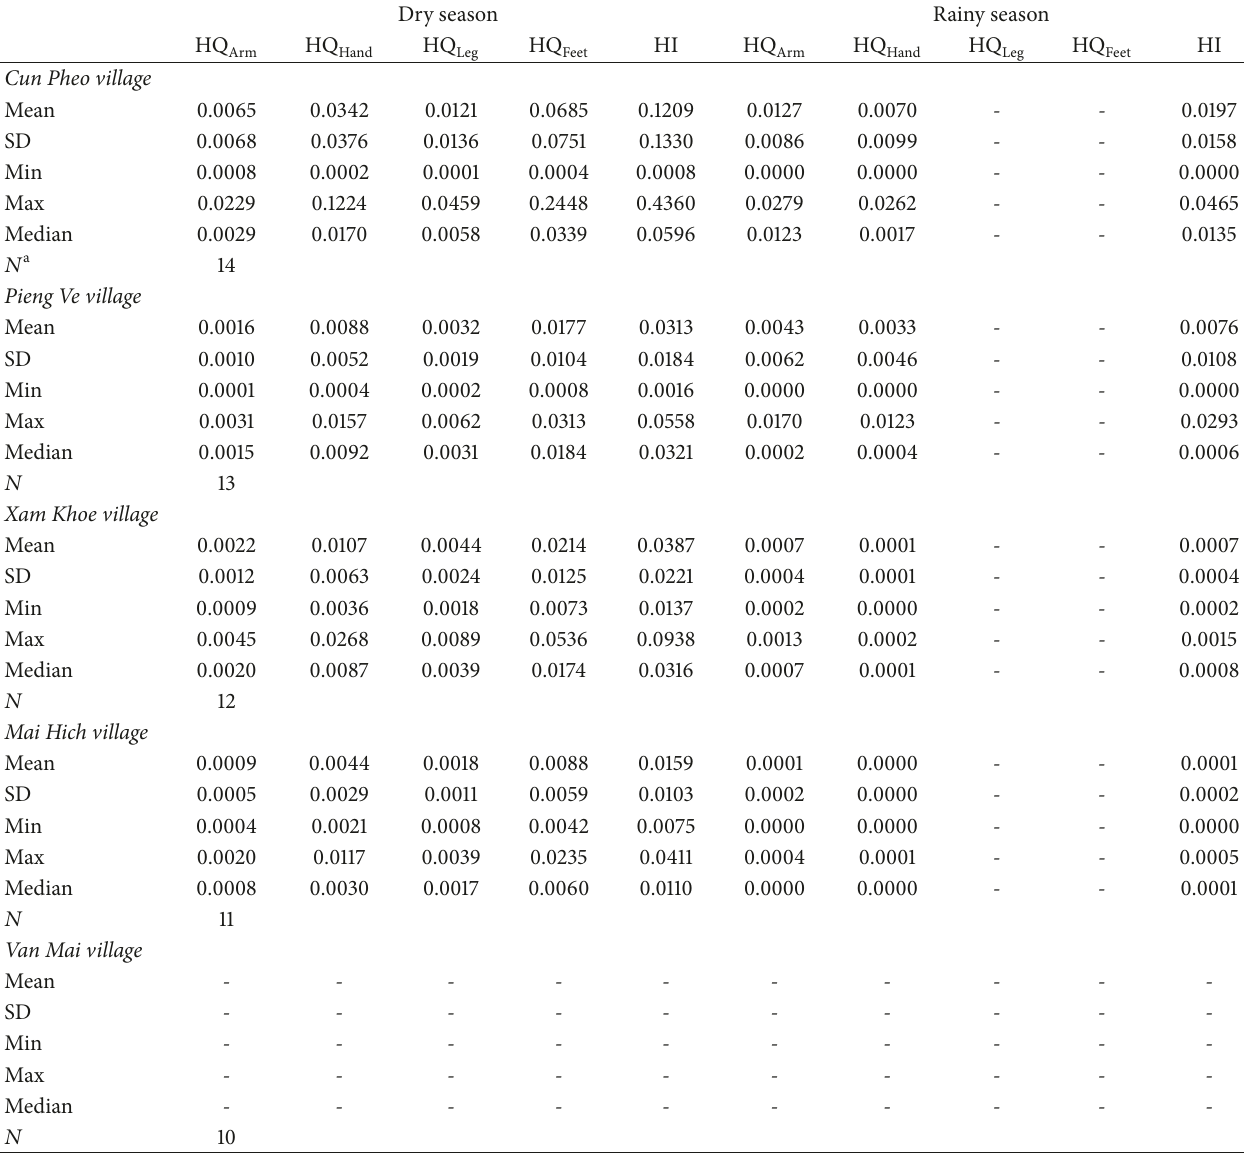
Table 3: The risk assessment values of the residents using stream water in the studied areas in the dry and rainy